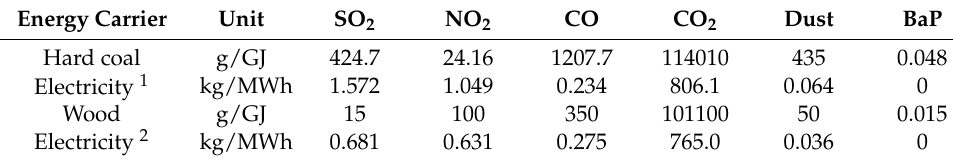
Table 6. Emission factors for hard coal, electricity, and wood [90–93].